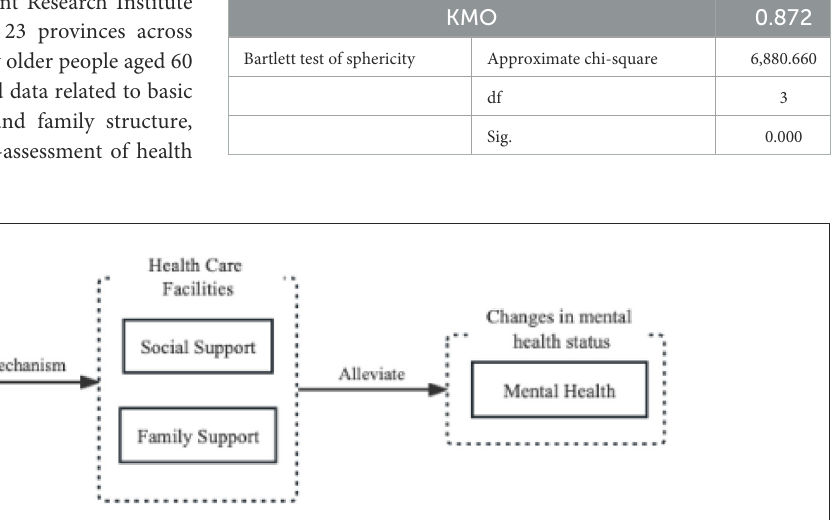
FIGURE1 Theoretical framework